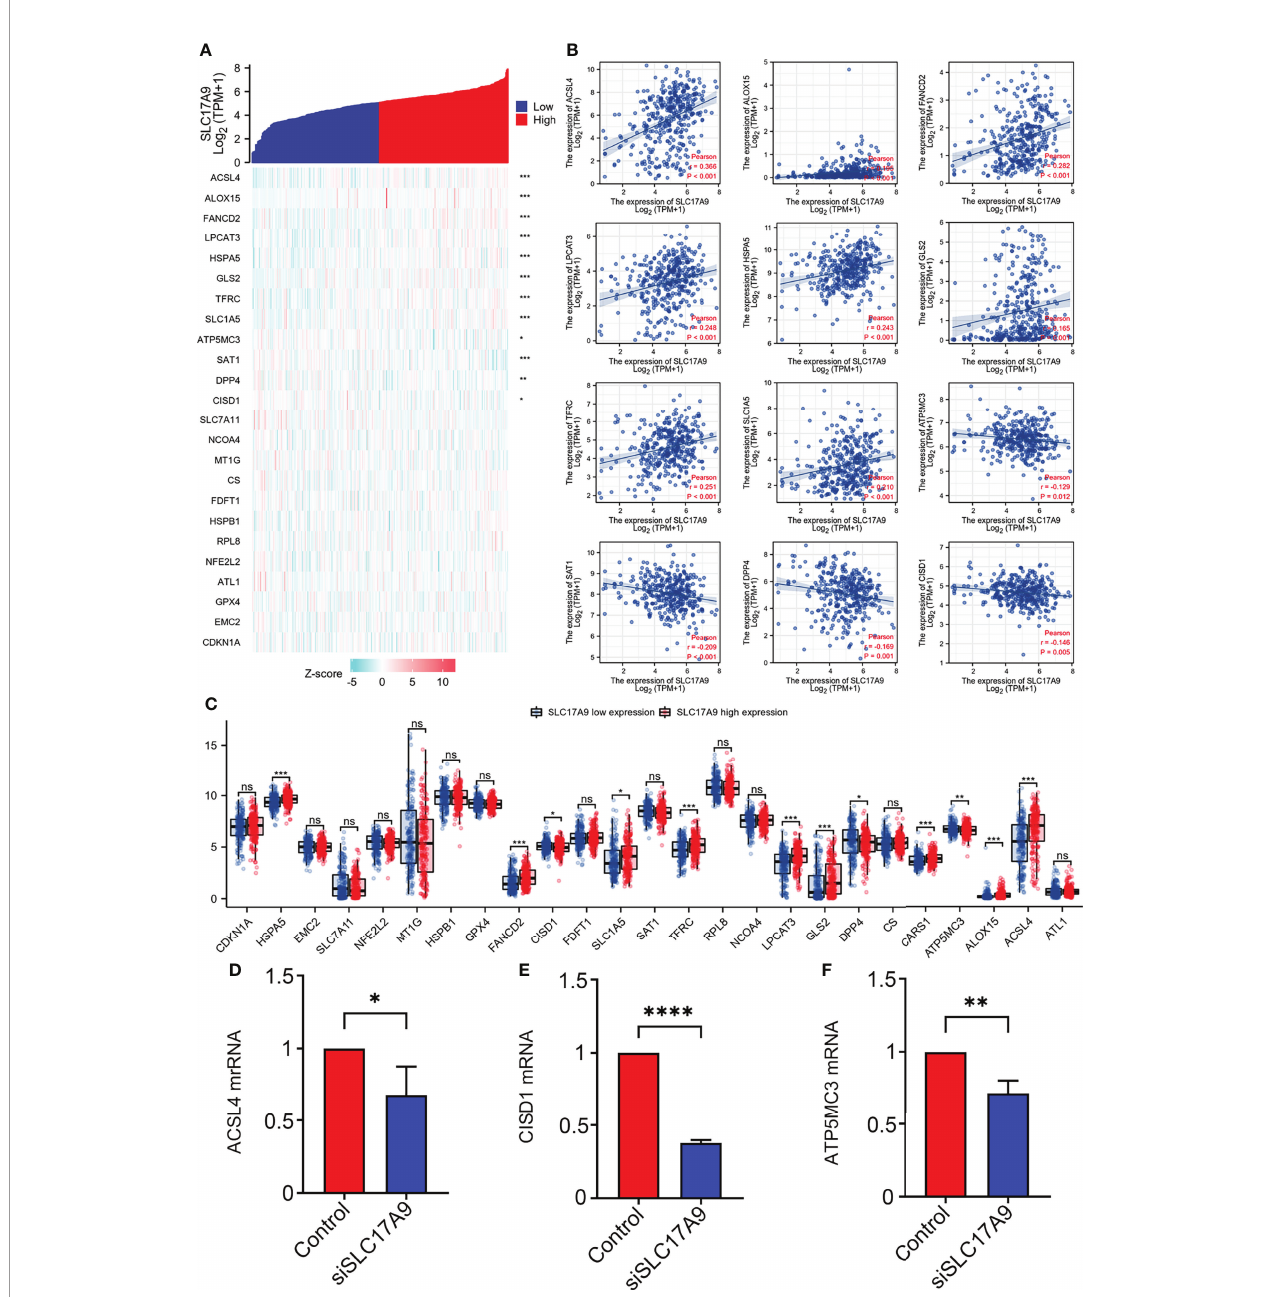
FIGURE 7 | Correlations of SLC17A9 expression with Fe de fi ciency-related genes in LIHC. (A) Thermography shows the correlation between the expression of SLC17A9 and Fe de fi ciency-related genes. (B) The scatter plot shows the correlation between the expression of SLC17A9 and Fe de fi ciency-related genes. (C) Expression of Fe de fi ciency-related gene in the high and low SLC17A9 expression groups in LIHC. (D) ACSL4 mRNA expression level in control and siSLC17A9 groups. (E) CISD1 mRNA expression level in control and siSLC17A9 groups. (F) ATP5MC3 mRNA expression level in control and siSLC17A9 groups. *p < 0.05; **p < 0.01; ***p < 0.001; ****p